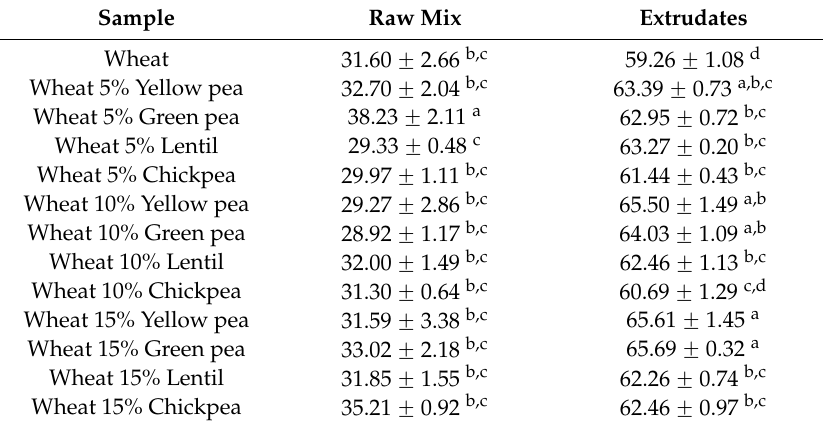
Table 4. Protein digestibility of raw flour mix and extrudates (given as a % of total protein in samples as determined by the Dumas